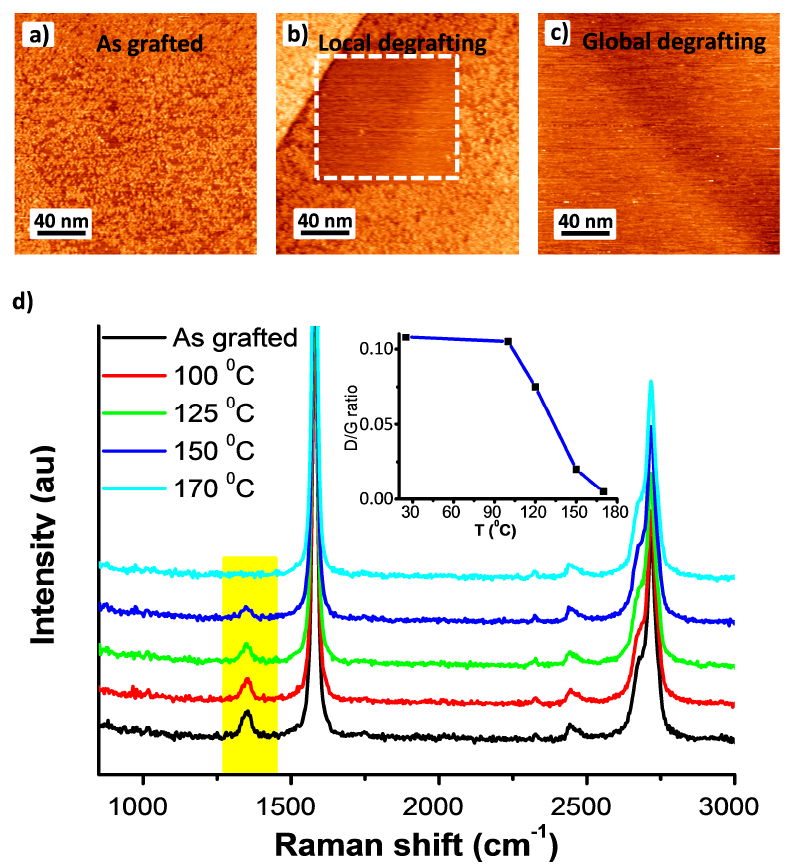
Figure 5. STM images recorded with respect to the 3,5-TFD-grafted HOPG surfaces ( a ) before and after degrafting: ( b ) locally by STM tip scratching and ( c ) globally by thermal treatment. Tunneling parameters: ( a , b ) I set = 0.08 nA, V bias = 0.5 V; ( c ) I set = 0.1 nA, V bias = 0.6 V. ( d ) Raman spectra of 3,5-TFD-grafted HOPG thermally treated at different temperatures for 10 min under ambient conditions. The spectra were averaged over 5 sample spots. Integration time: 100 s; insert shows the temperature-dependent I D /I G